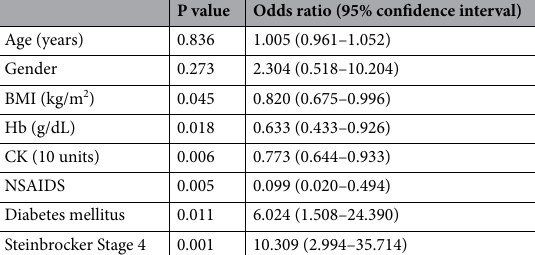
Table 3. Logistic analysis by forward stepwise method for Group A and Group B. Hosmer Lemeshow Test p = 0.683. BMI body mass index, Hb hemoglobin, CK creatine phosphokinase, NSAIDS non-steroidal anti- inflammatory